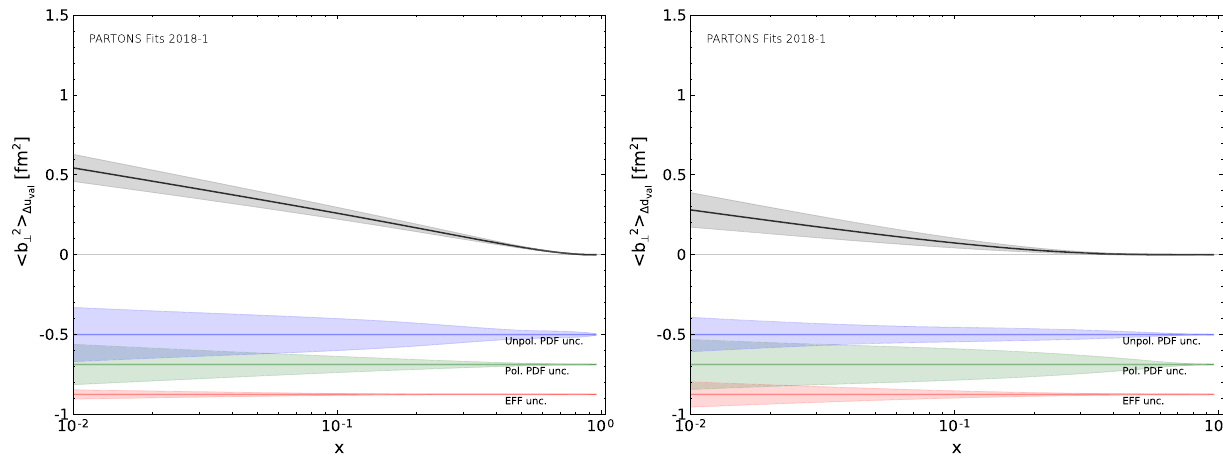
Fig. 17 Normalized second moment of the Δ q val ( x , b ⊥ ) distribution for up (left) and down (right) quarks as a function of the longitudinal momentum fraction x . For further description see Fig. 6